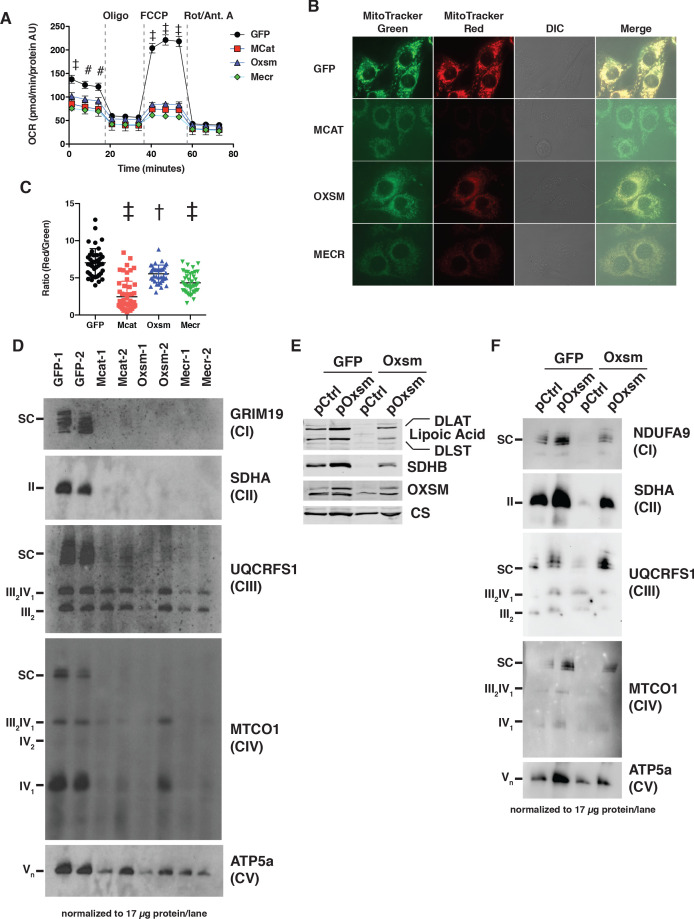
MtFAS mutants display profound loss of mitochondrial respiration and ETC complexes.(A) Cells from three clones of each of the indicated genotypes were seeded in eight wells of a 96-well seahorse plate and allowed to adhere overnight, then equilibrated and treated with the indicated drugs following standard mitochondrial stress test protocols from the manufacturer to determine Oxygen Consumption Rate (OCR). #=p < 0.01, †=p < 0.001, ‡=p < 0.0001 all comparisons are to GFP control, error bars are SEM. (B) Cells of the indicated genotype were seeded in chambered coverglass slides, stained with Mitotracker Red and Mitotracker Green, and imaged. (C) Ratio of MitoTracker Red to MitoTracker Green fluorescence of cells from 30 fields of view quantified using Fiji ImageJ. *=p < 0.05, †=p < 0.001, ‡=p < 0.0001 all comparisons are to GFP control, error bars are SD. (D) Mitochondrial lysates generated from the indicated cell lines were normalized for total protein by BCA assay, incubated with 1% digitonin, then separated by blue-native PAGE and immunoblotted with the indicated antibodies.